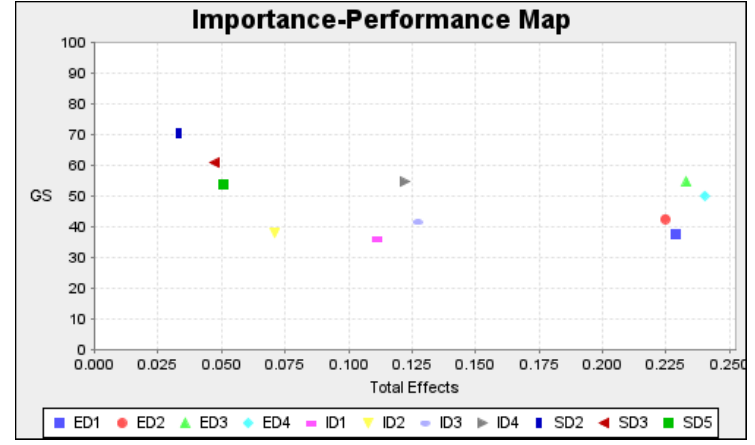
Figure 3. IPMA Diagram.